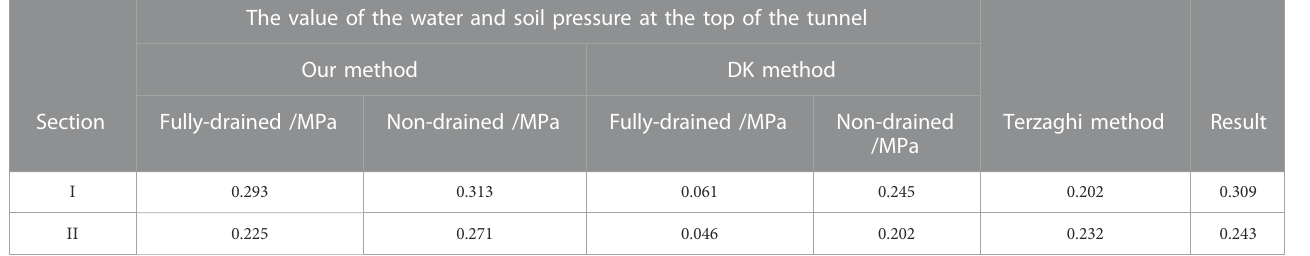
TABLE 3 Comparative analysis of